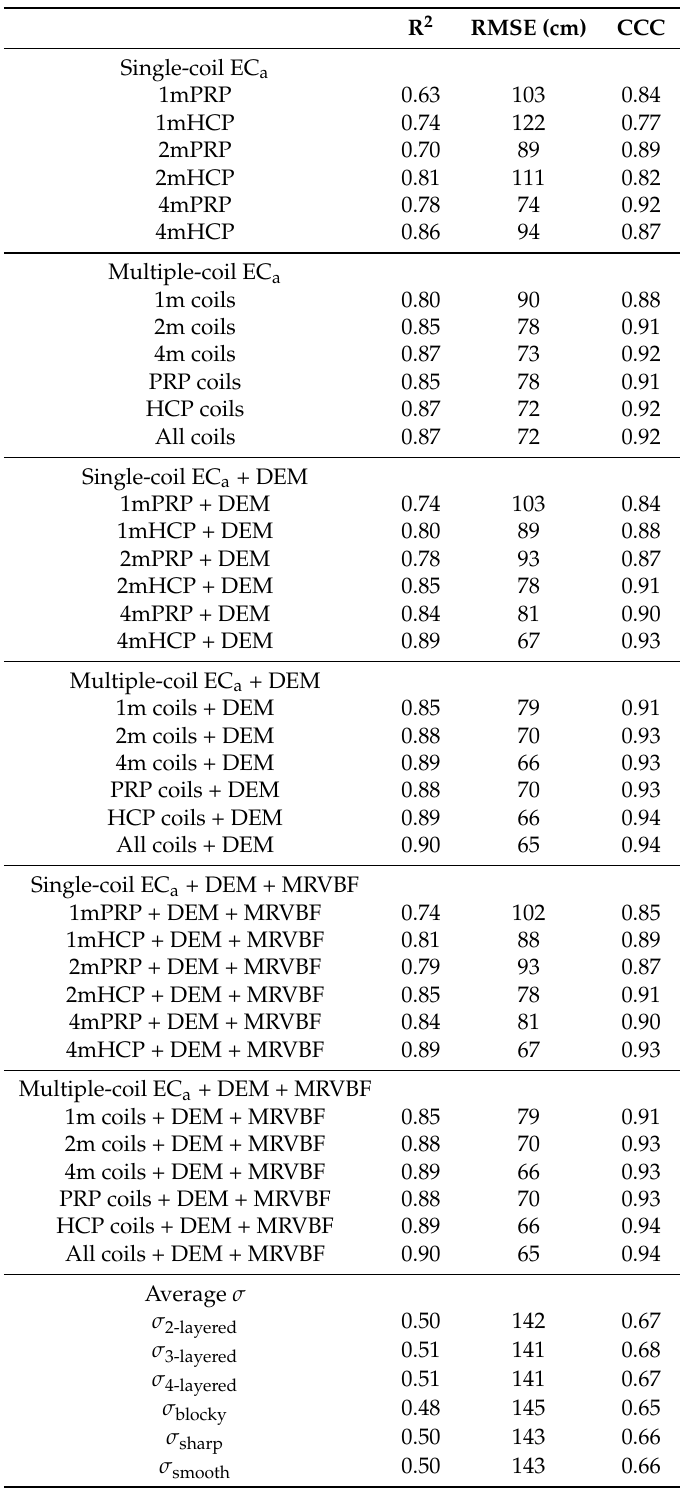
Table 4. LOOCV performance metrics for models predicting peat thickness from single-coil EC a data (LR), different combinations of EC a data (i.e., multiple-coil predictions) and environmental covariates (MLR), and from the average σ calculated using different inversion models (LR). R